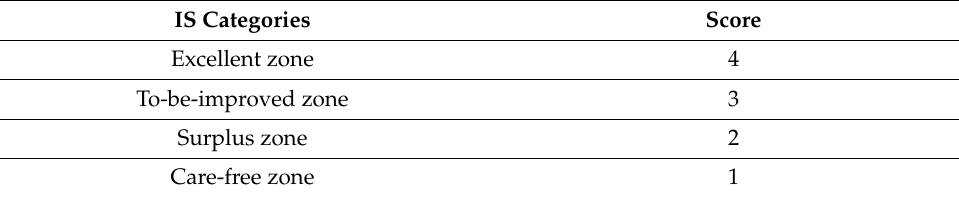
Table 1. Scores for each IS category.